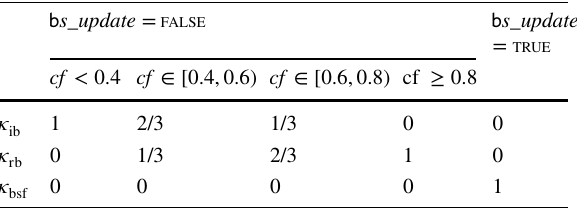
Fig. 1 Illustrative example of the negative learning A CO approach for the MaxSAT problem Table 1 Values of 𝜅 ib , 𝜅 rb , and 𝜅 bsf based on the convergence factor cf 𝖻 s _ and the Boolean control variable